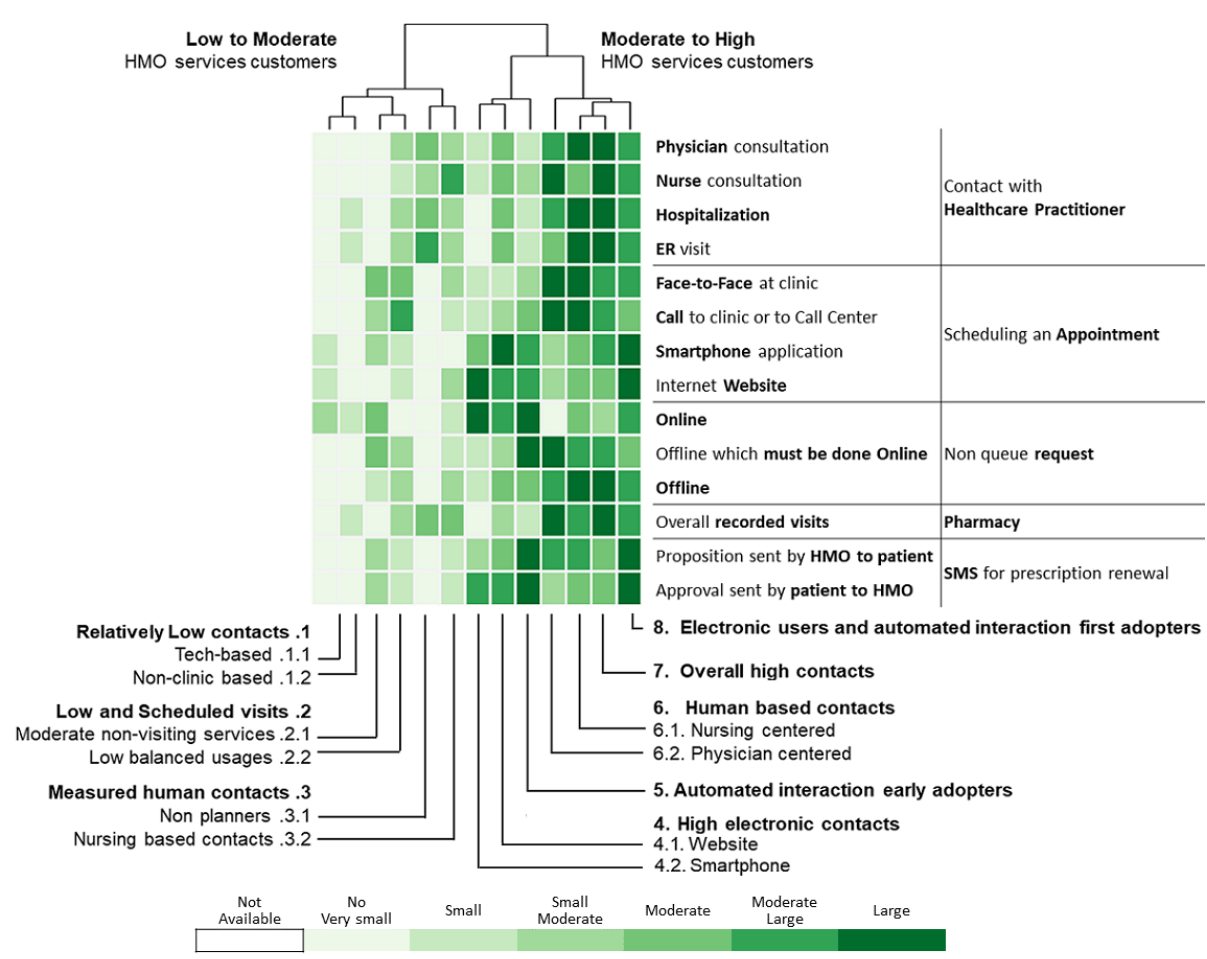
Figure 2. Communication patterns in 2016 of 311,168 patients with diabetes (members of the Clalit Health Services). HMO: health management